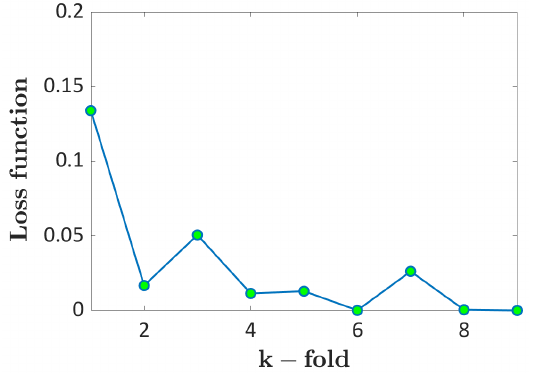
Figure 16. k-fold cross-validation: loss function with respect to the k-fold considered for the validation.